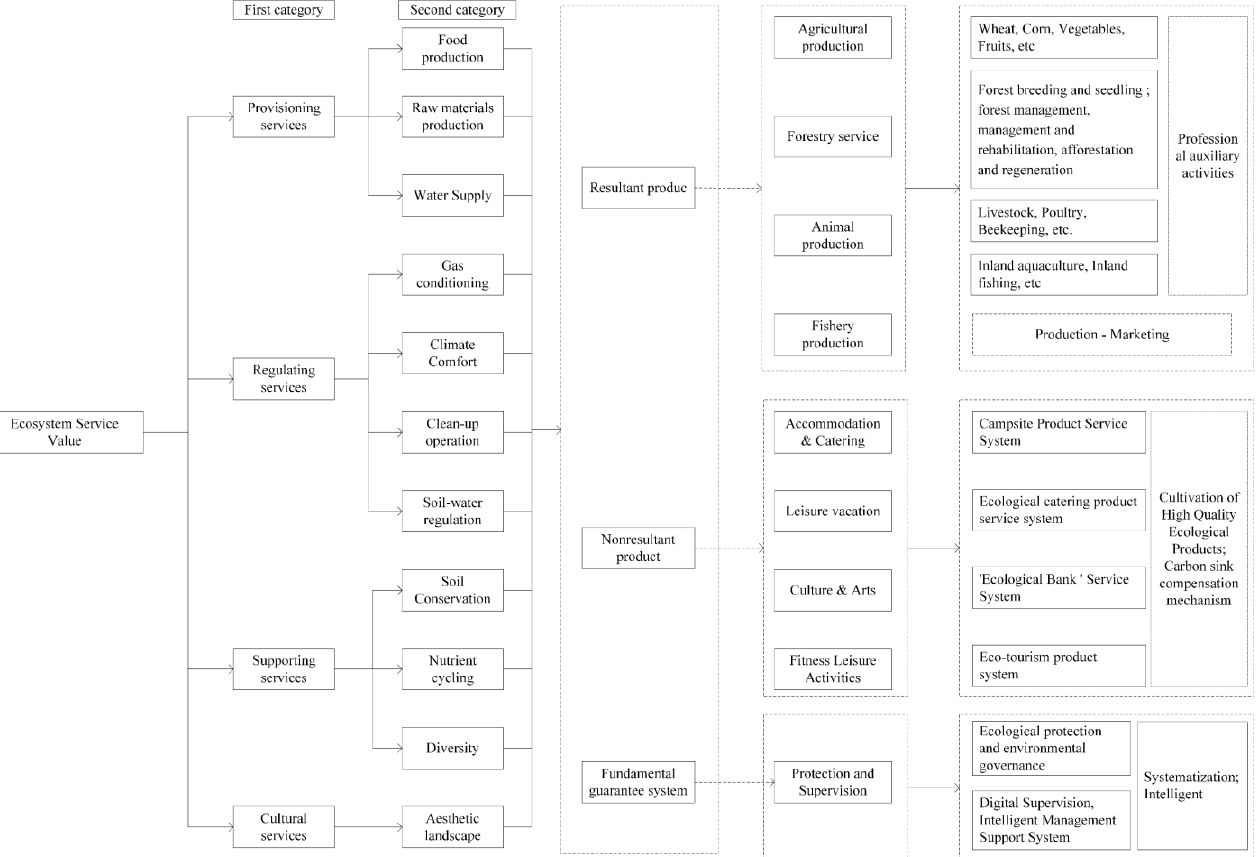
Figure 5. Industrial system construction diagram.